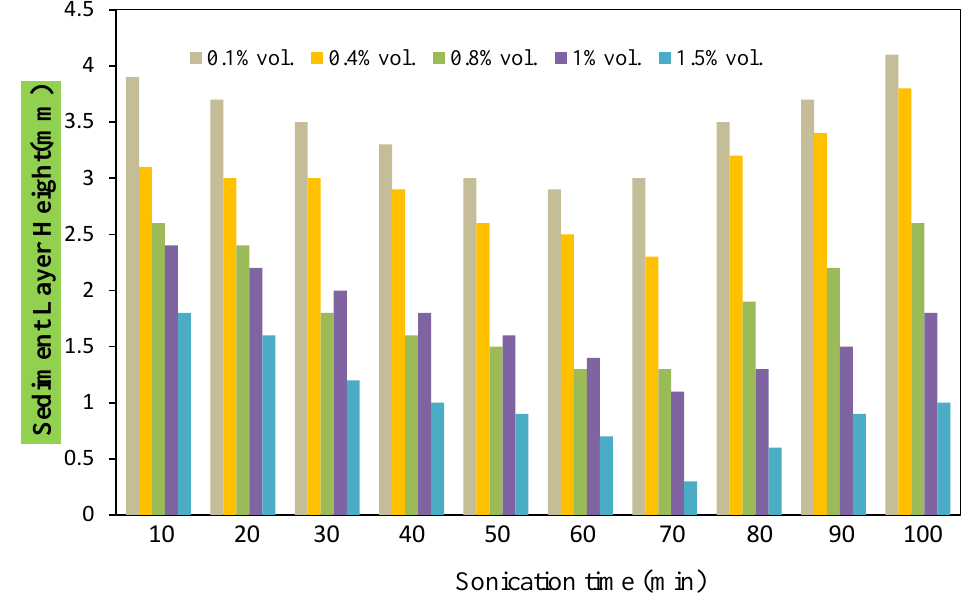
Figure 2. Effect of sonication time on the stability of CuO/glycerol nanofluid.